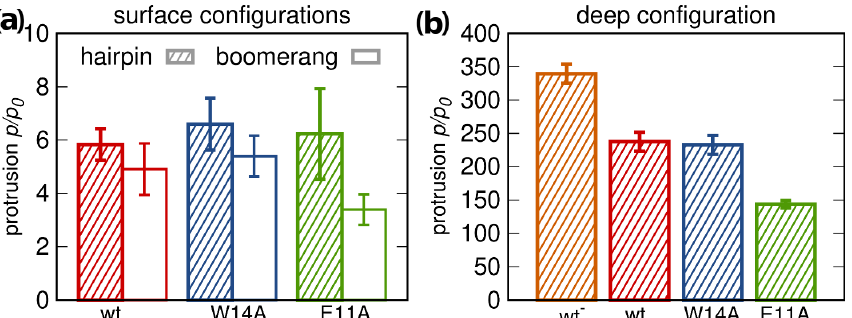
Figure 6. Ratios of lipid tail protrusions within 7 Å distance from peptides to those in pure POPC membrane for: ( a ) surface; and ( b ) deep